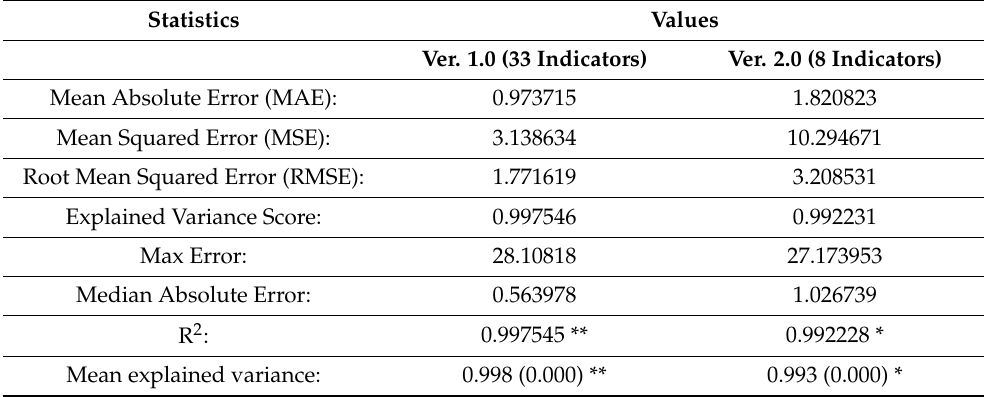
Table 1. Model statistics. Source: authors’